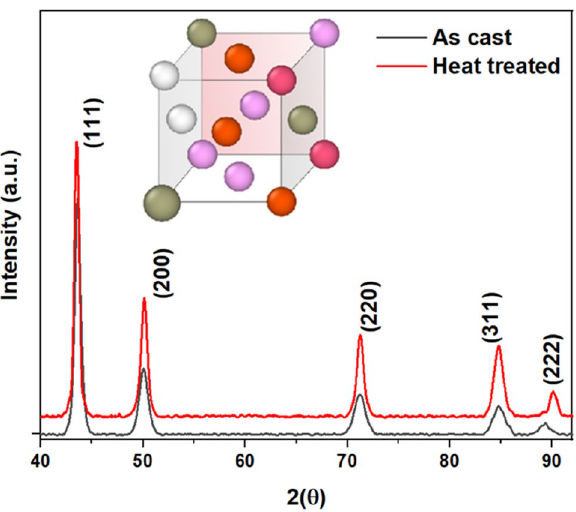
Figure 8. XRD analysis of newly synthesized HEA (Ni 25 Cu 18.75 Fe 25 Co 25 Al 6.25 ) for as-cast and heat-treated sample. Peaks (111), (200), (220), (311) and (222) correspond to the FCC structure.